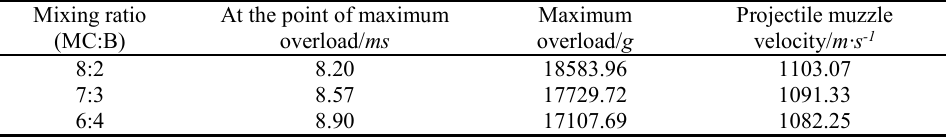
Table 3. Influence of mixing ratio on internal ballistic overload